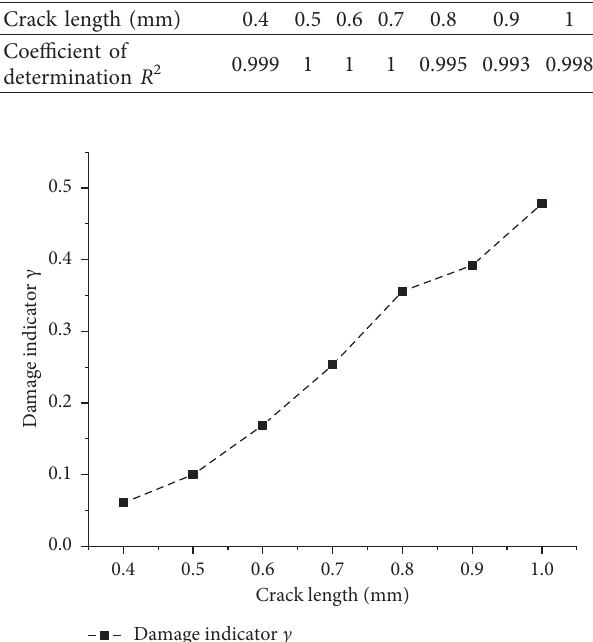
Figure 5: Damage indicator c for various crack lengths.